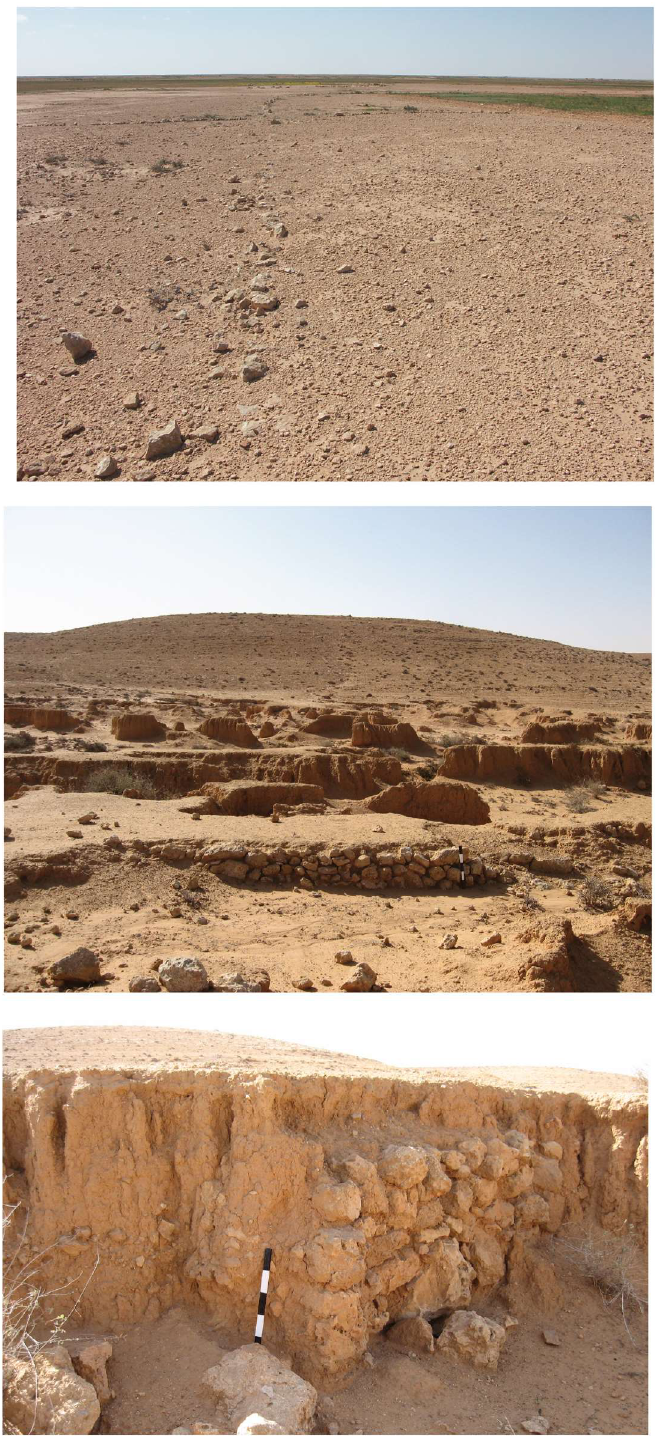
Figure 13. Embankment on the tableland for creating cultivable areas (Hâggag Midâr) (top); cross sectional dams in the bed of Wadi Kharouba, section (middle); surface view on a dam/terrace in the bed of Wadi Kharouba (below). Photographs: A.-K. Rieger.